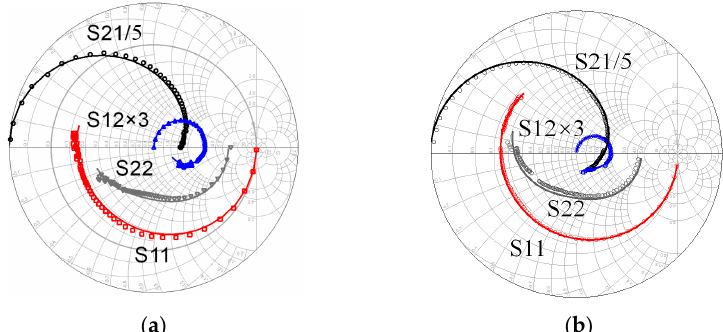
Figure 8. Comparison of simulated and measured S-parameters: ( a ) 4 × 20 µm at Vgs = − 2 V, Vds = 10 V and ( b ) 4 × 50 µm at Vgs = − 1 V, Vds = 15 V.